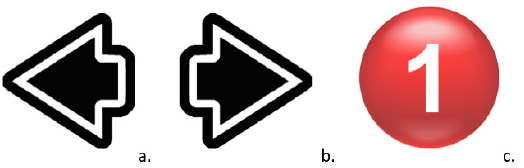
Figure 5. Sub-symbols for interface navigation—( a , b ) Arrows for interface navigation to previous or next message, ( c ) Red Sphere with the number of messages received.